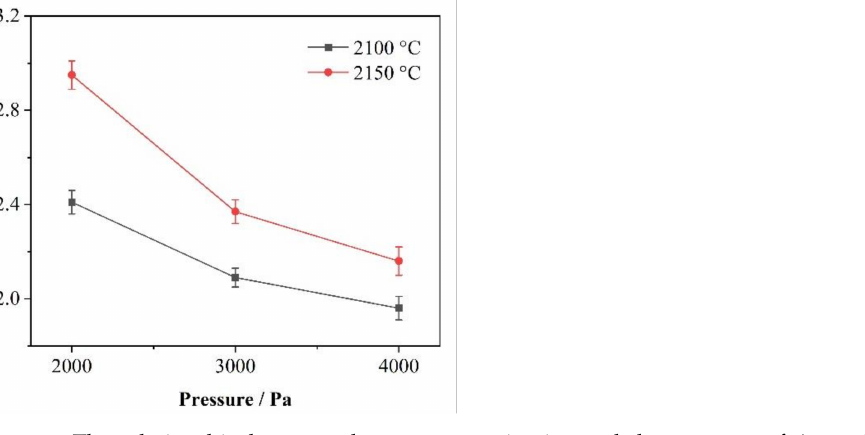
Figure 7. The relationship between the average grain size and the pressure of Ar at different temperatures.